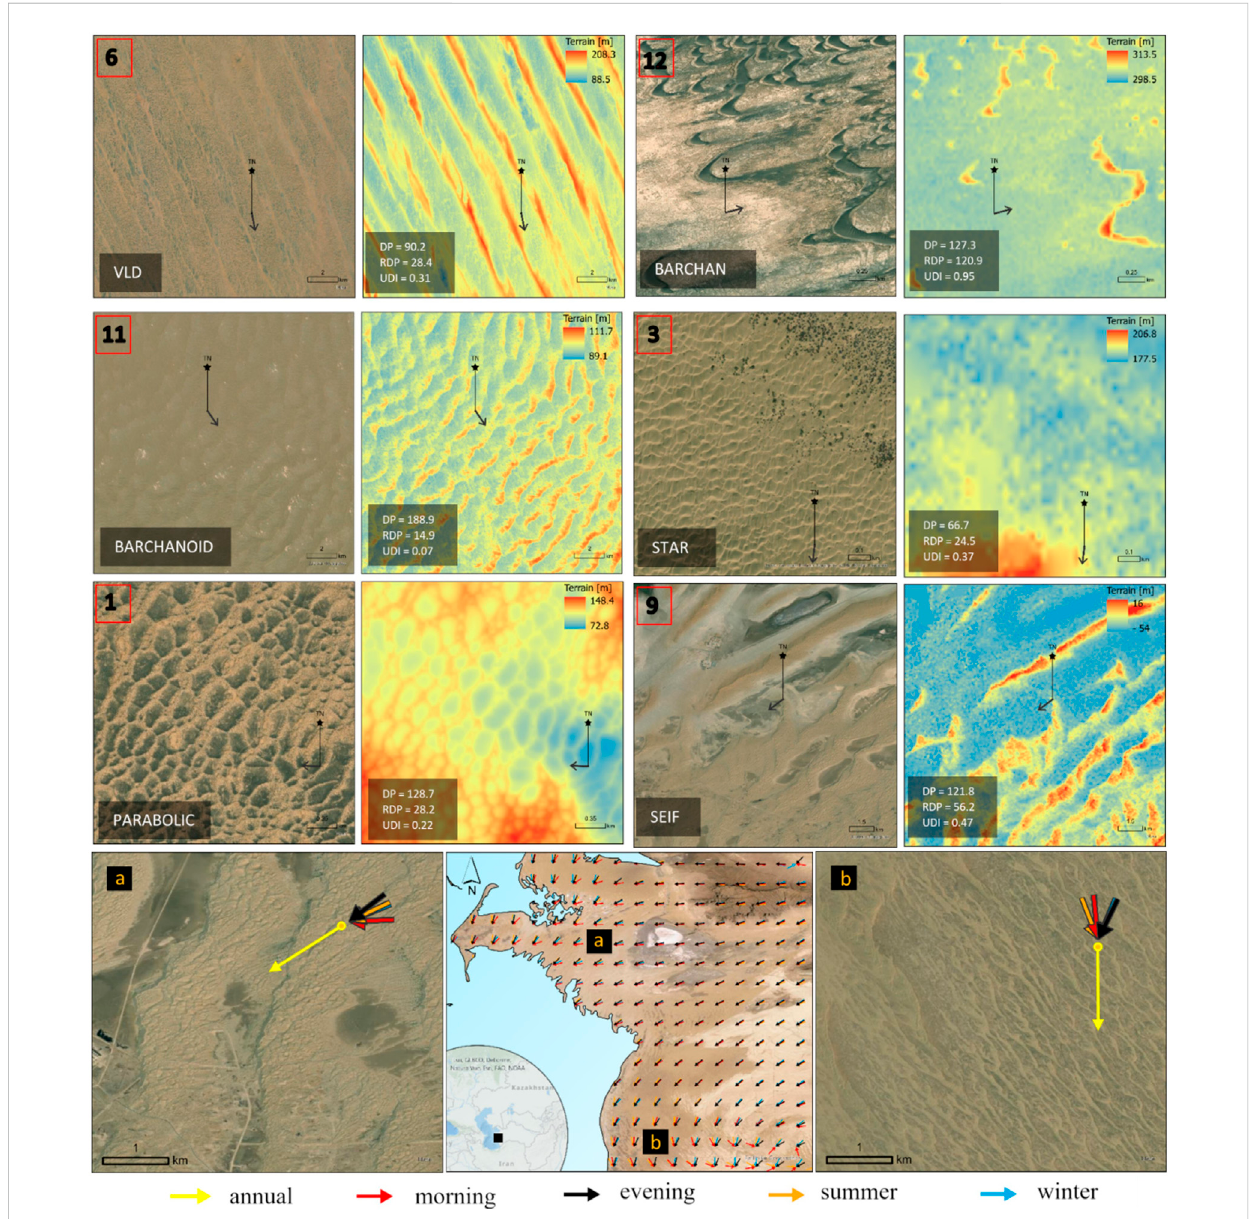
FIGURE 11 Dunetypesrecognizedintheareaandtheirdriftpotential(DP)calculationsforthestatisticalperiod2010 – 2019.Thenumberintheupperleftcorner standsforthecorrespondingwindowinFigure 2.TheCostalCaspianregionissplitintoNorthernHemisphereseasons,winter(November – February)and summer (May – August), as well as the geomagnetic time hour of sampling of the reanalysis data, 06:00 h and 18:00 h, for 2010 –